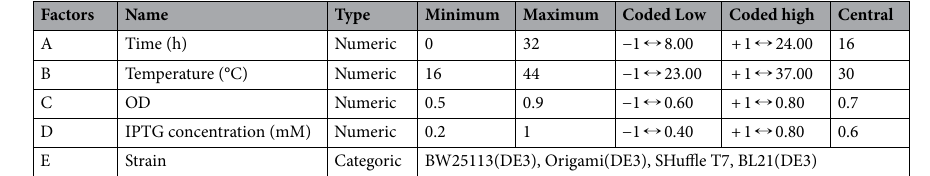
Table 1. Coded values of numerical and categorical variables used in central composite design.